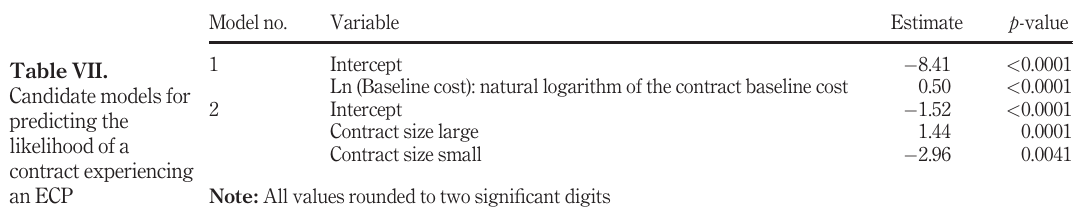
Table VIII. Confusion matrices for the two logistic regression candidate models for predicting the likelihood of a contract experiencing an ECP